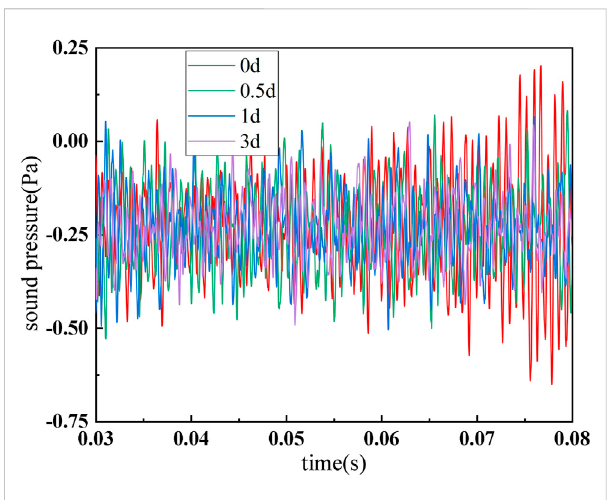
FIGURE 13 Time domain pressure results with different offsets.